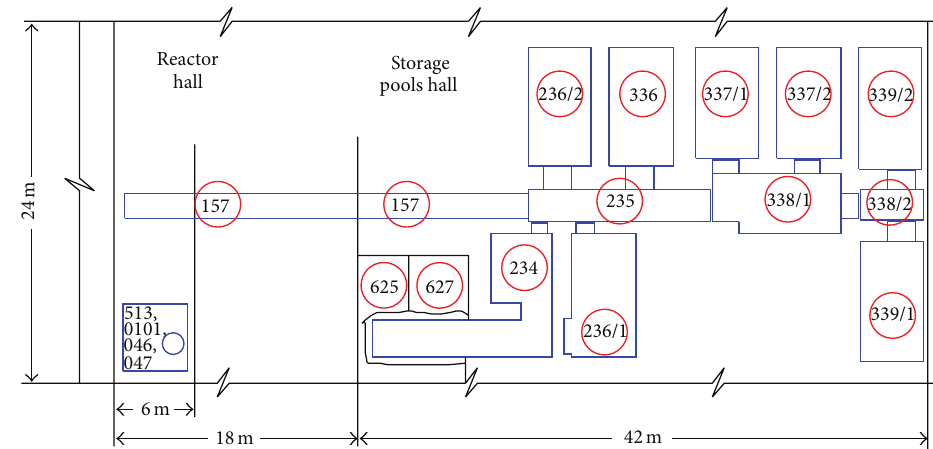
Figure 1: Layout of buildings in SFPs hall of Ignalina NPP Unit